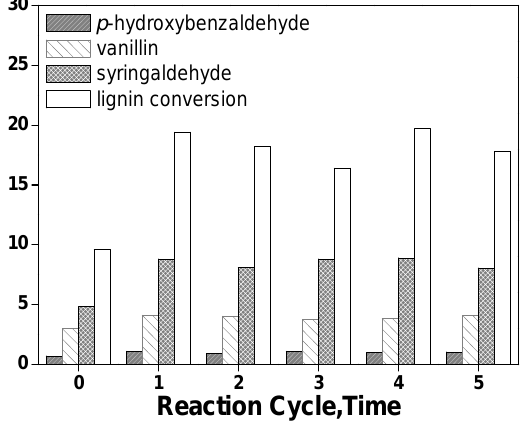
Figure 7. Lignin conversion and yield of aromatic aldehydes in the absence of catalyst (process 0) and five successive runs of LaFeO indicated in Figure 5).